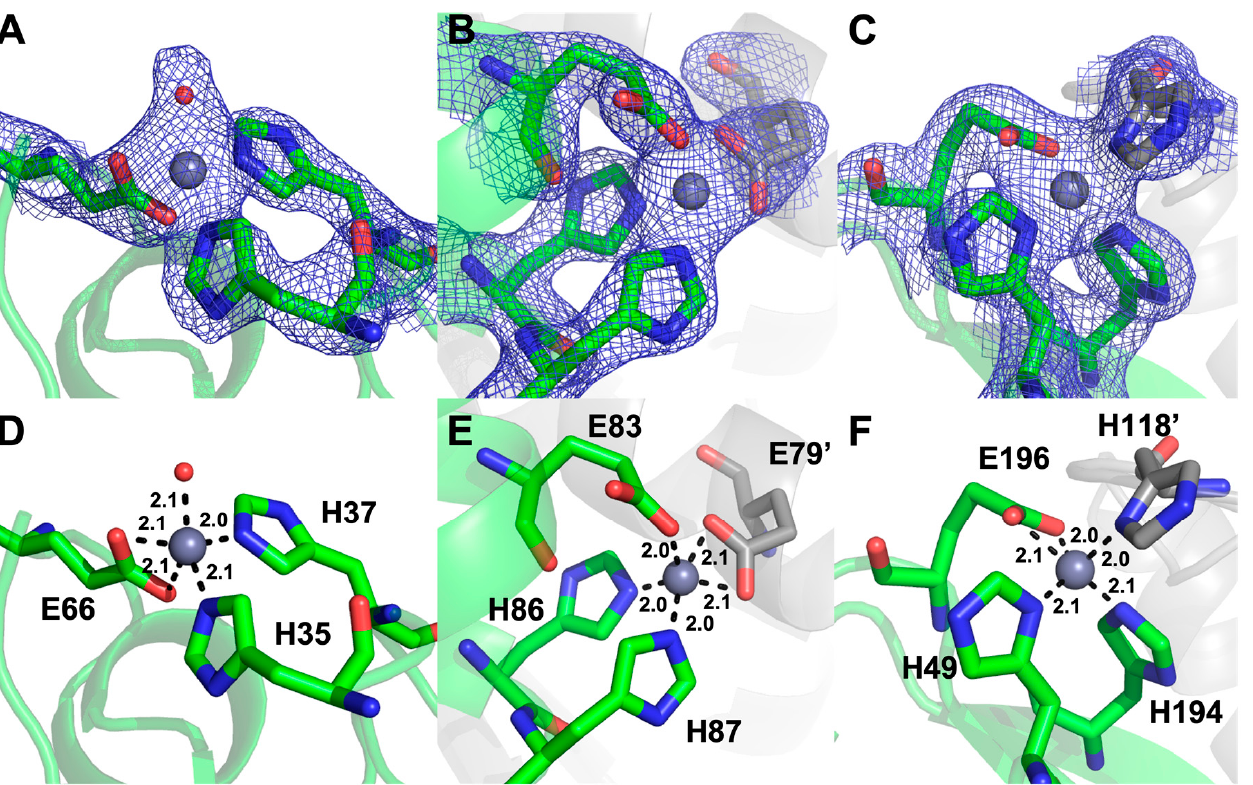
Figure 5. Zinc binding sites in Δ 124-184 ZrgA showing 2Fo-Fc density contoured at 1.5 σ ( A – C ) and zinc ligands with bond distances indicated in Å ( D – F ). Site 1 ( A , D ), site 2 ( B , E ), and site 3 ( C , F ) are shown for the A chain (green) with ligands contributed from the D chain (gray) indicated by (’). Figure created with Pymol version 2.5.4, Schrödinger, LLC. New York, NY, USA. Although the structures of apo and holo ZrgA are very similar with RMSD ~ 0.5 Å, they do reveal a few interesting conformational changes accompanying zinc binding (Figure 6), particularly near site 1. As was observed for PA4063, site 1 ligands His 35 and His 37 become ordered upon metal binding. Further, the loop containing Glu 66 moves approximately 4 Å to allow zinc coordination (Figure 6B). In order to accommodate this motion, the N-terminal side of the flexible loop (modeled residues 121–123) must also reorient a comparable distance. The side chains of site 2 ligands Glu 83 and His 86 reorient on zinc binding as well (Figure 6C) while only very modest side chain movement is observed at site 3 (Figure